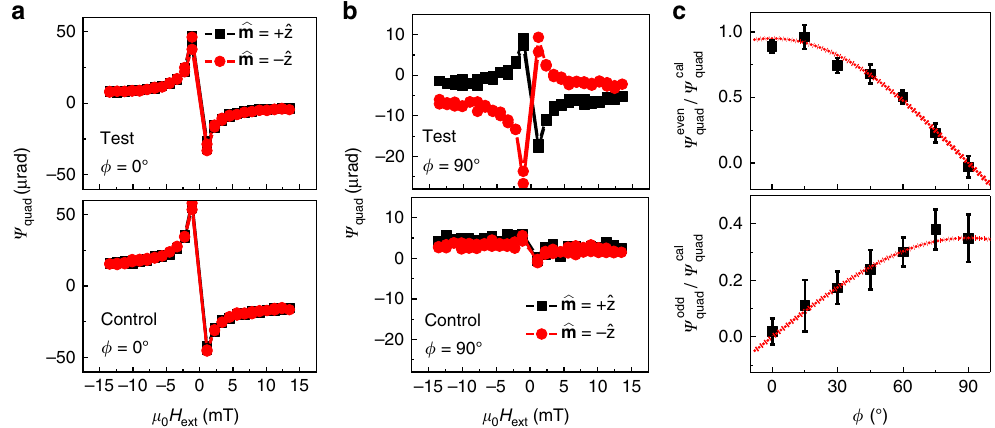
Fig. 3 Current-induced fi eld-like torque. Here we use quadratic MOKE magnetometry to measure current-induced in-plane effective fi elds in the same con fi guration as shown in Fig. 2a. In this measurement, normal incidence light with linear polarization along the x -direction is used. Although in this measurement, the polar MOKE signal is also detected, it is much weaker than the quadratic MOKE response and can be distinguished from fi ttings. a The quadratic MOKE response measured in the test and control samples when current is applied parallel to H ext . No dependence on the initial magnetization of the PML, ^ m , is observed. b The quadratic MOKE response measured in the test and control samples when current is applied perpendicular to H ext . In the test sample, the quadratic MOKE response is reversed when ^ m is reversed. On the contrary, the weak quadratic MOKE response in the control sample, which is likely due to small misalignment of H ext , has little dependence on ^ m . c The angle dependence of ψ even and ψ odd of the test sample. Here quad quad the values are extracted by performing a linear fi tting with ψ cal , which is the quadratic MOKE response measured with an external AC calibration fi eld of quad (cid:1) (cid:3) = ψ cal = ψ cal = ψ cal ¼ 0 : 95 cos π ϕ 117 ± 10 Am − 1 . The slope is extracted and plotted here as ψ even and ψ odd , respectively. Red lines are fi ttings with ψ even quad quad quad 180 quad quad quad (cid:1) (cid:3) = ψ cal ¼ 0 : 35 sin π ϕ and ψ odd . The error bars represent the standard deviation associated with the linear fi tting performed on ψ cal quad 180 quad